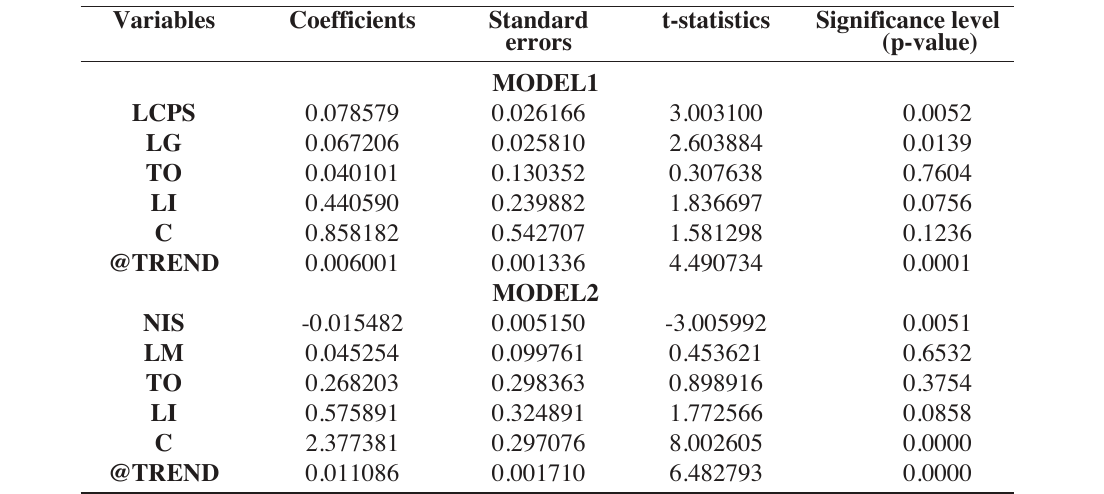
Table 5. Long-run relationship an ARDL results of model 1 and 2